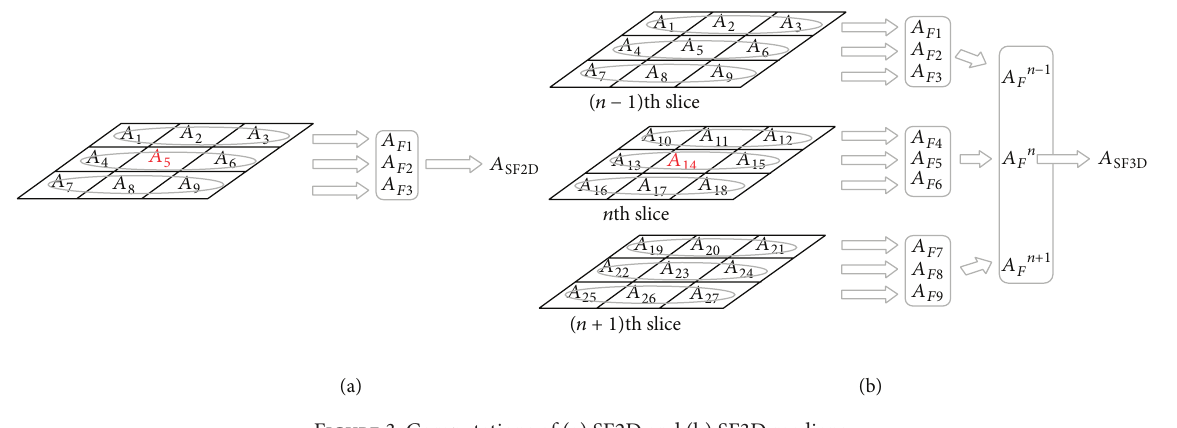
Figure 3: Computations of (a) SF2D and (b) SF3D